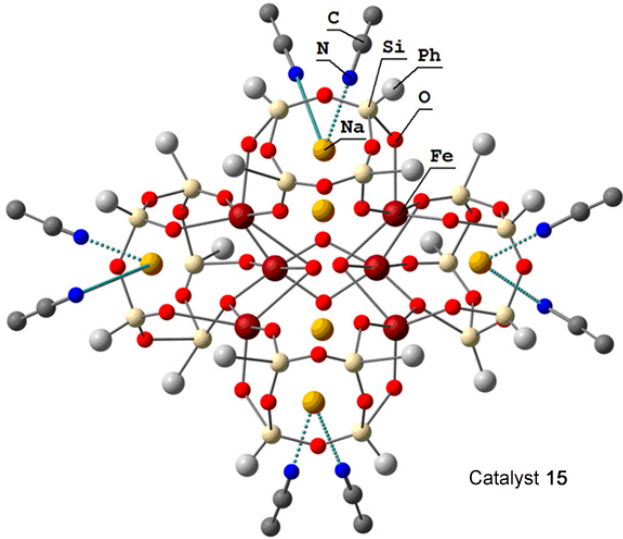
Figure 9. Molecular structure of hexairon compound 15 . Adapted from Ref. [226].